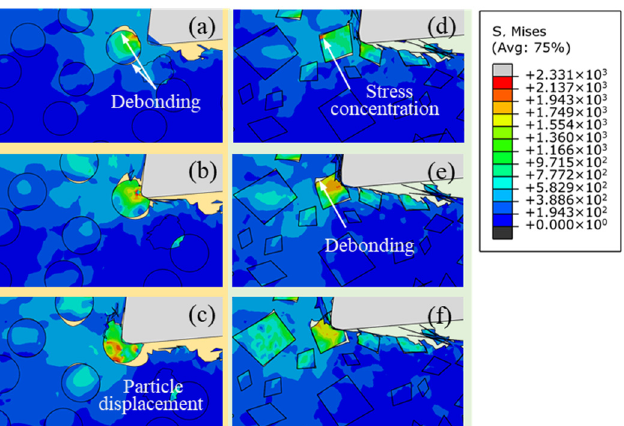
Figure 7. Stress distribution of particles below the cutting path with different particle shapes: ( a – c ) circular particles; ( d – f ) irregular polygonal particles. ( a – c ) circular particles; ( d – f ) irregular polygonal